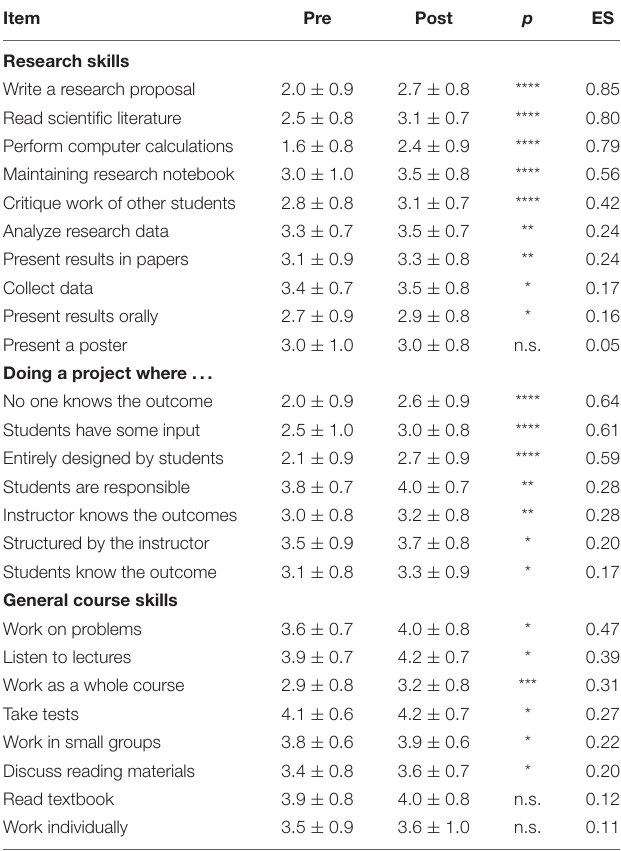
TABLE 3 | Classroom undergraduate research experience